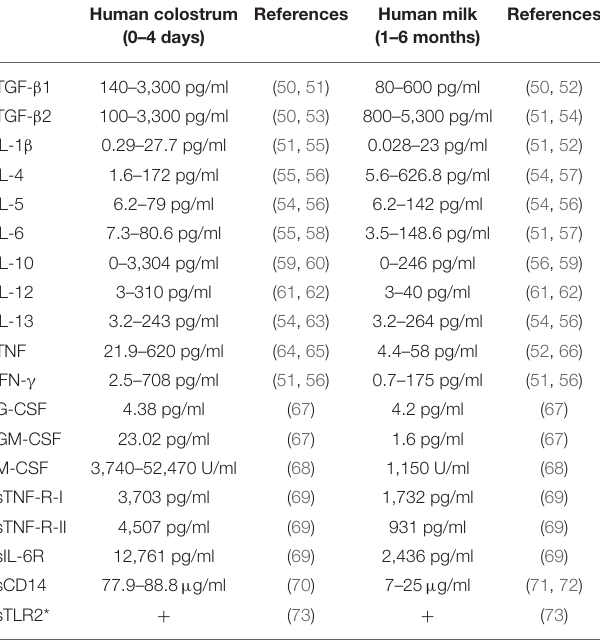
TABLE 1 | Concentrations of cytokines and soluble receptors in human colostrum and human